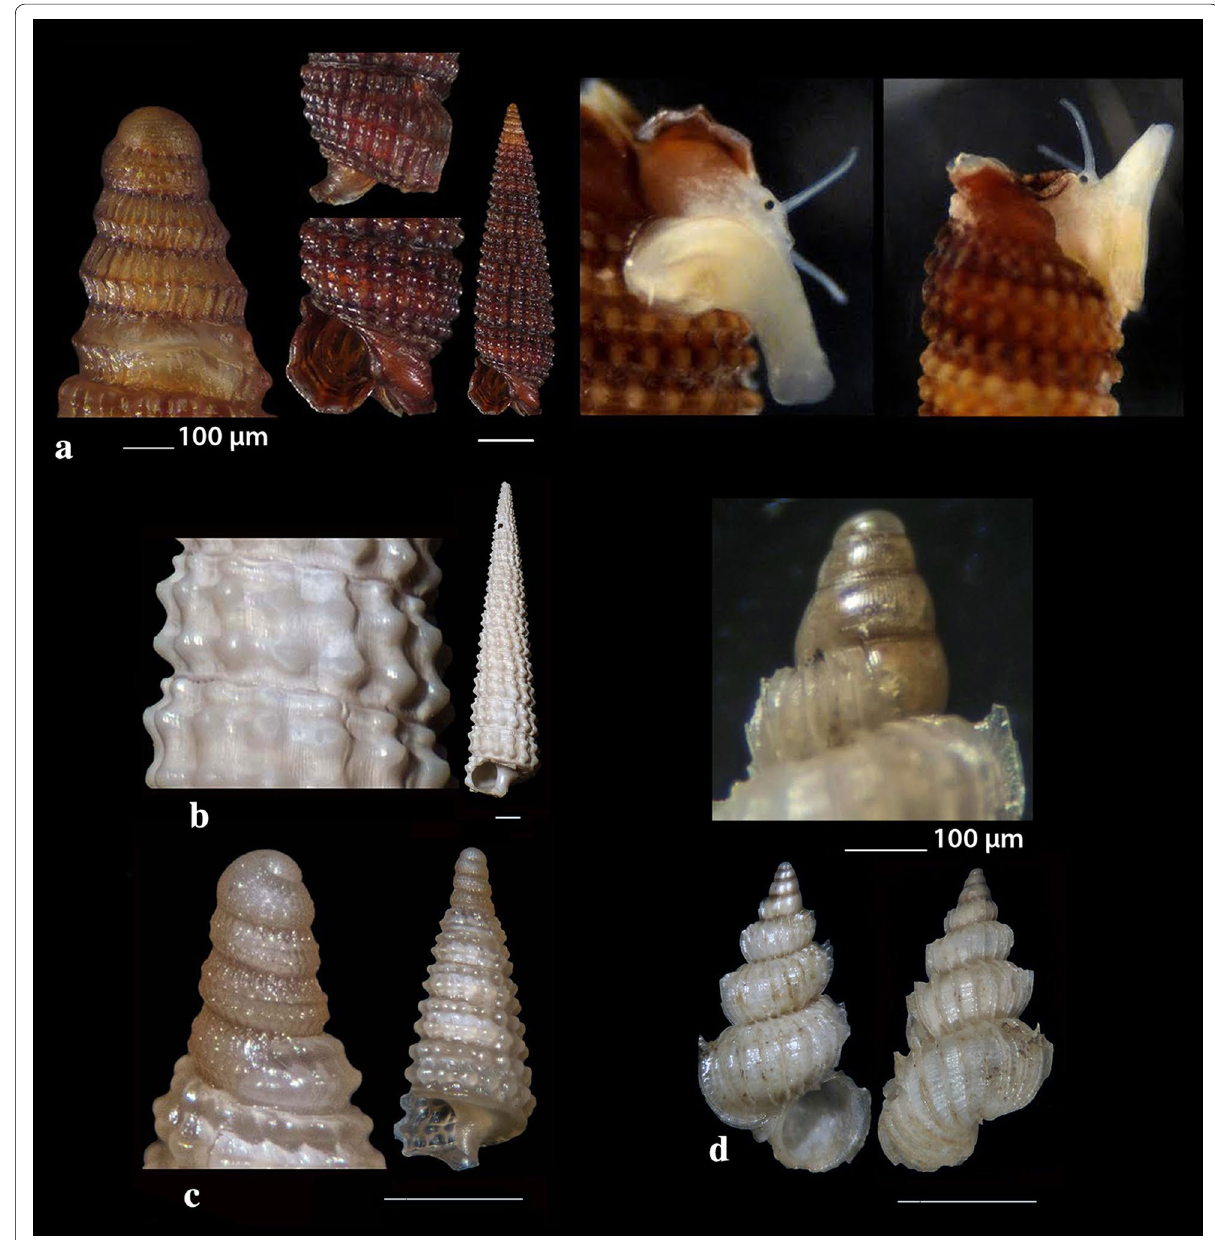
Fig. 16 a Obesula marisnostri , b , c Strobiligera brychia , d Epitonium tryoni . Bar